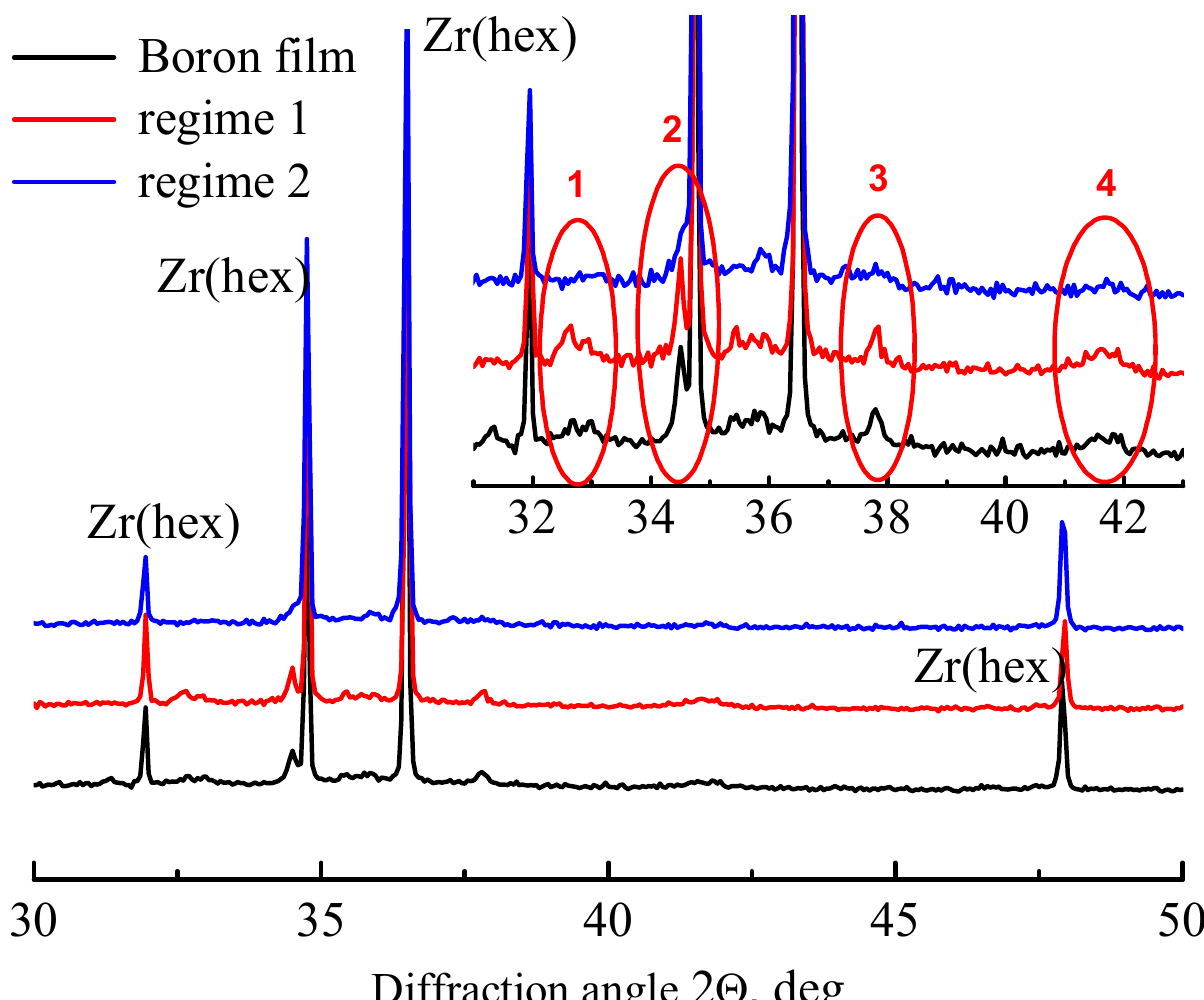
Figure 6. X-ray patterns of the surfaces of boron coatings on samples of the ZrNb1 alloy with a hexagonal crystal lattice. The inset shows the regions where the reflections of crystalline boron appear: regions 1, 2, 3, and 4. The wavelength of synchrotron radiation is 0.154 nm.